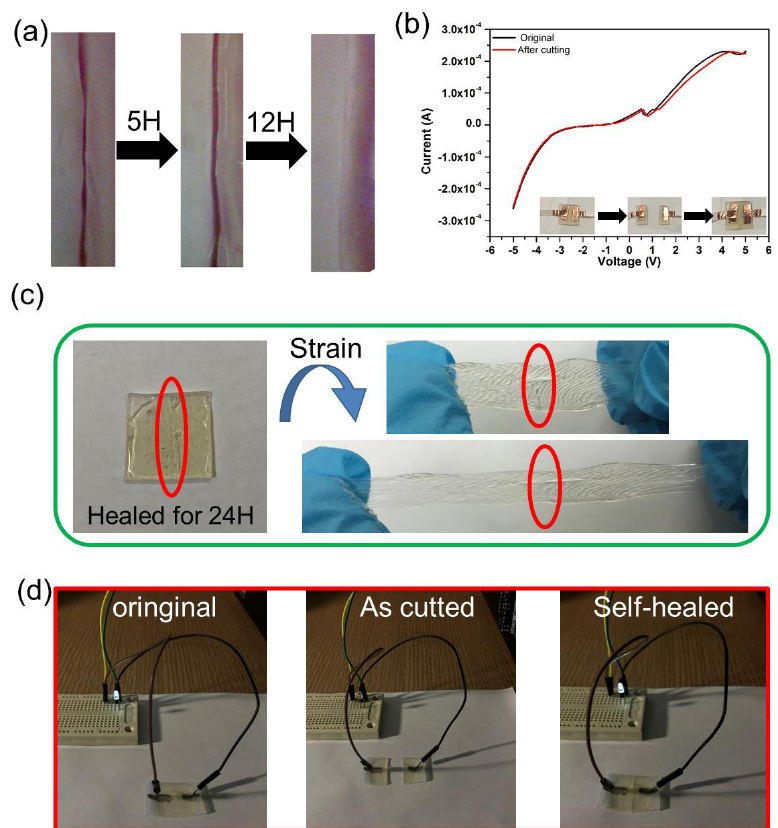
Figure 3. ( a ) The morphology and ( b ) the current-voltage curves of the ionogel film before and after self-healing. ( c ) The photograph of the stretching of the repaired ionogel film. ( d ) The circuits based on the ionogels, cut ionogels, and self-healed ionogels.